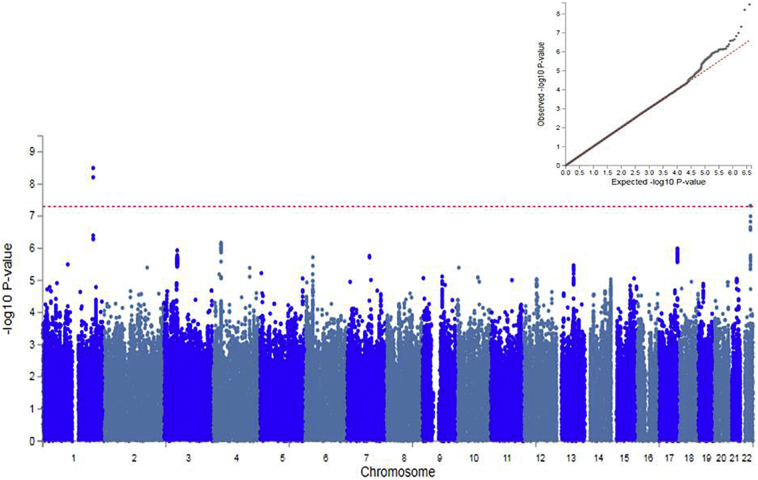
SNP Manhattan plot and QQ plot (inset) of low RA GWAS (N = 2700 cases verses N = 68,300 controls).Red line of Manhattan plot represents genome-wide significance (p < 5 × 10−8).